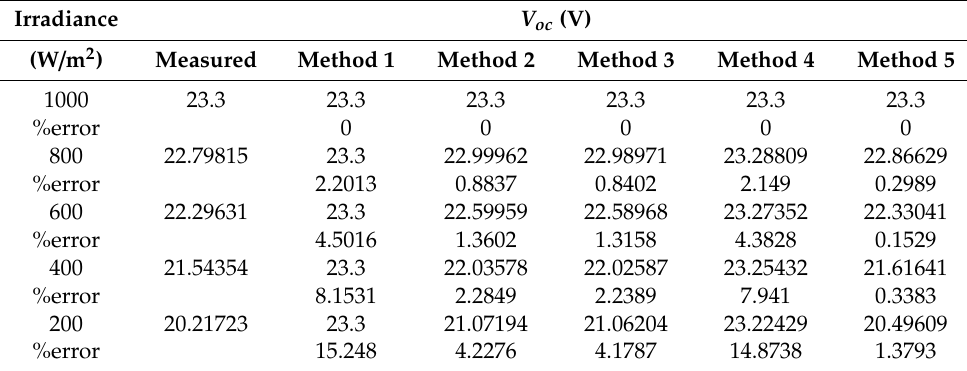
Table 8. The calculated and measured V oc (V) and relative error of the shell ST40 module under di ff erent irradiance levels and a temperature of 25 ◦